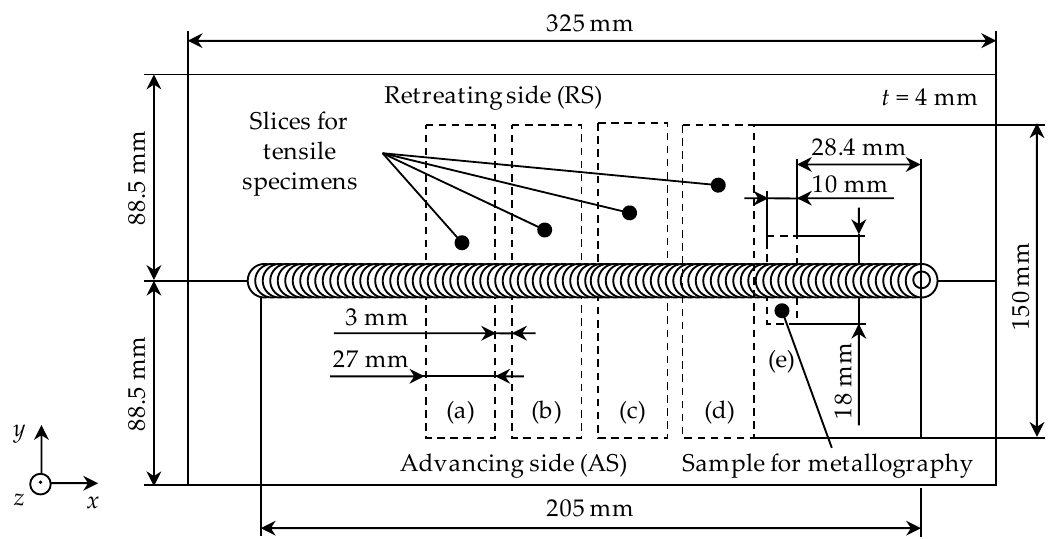
Figure 1. Sheet metals in the butt-joint configuration with sampling areas for the material tests.